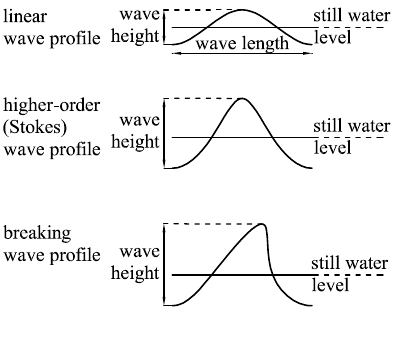
Figure 10. Schematic representation of wave profiles corresponding with different wave